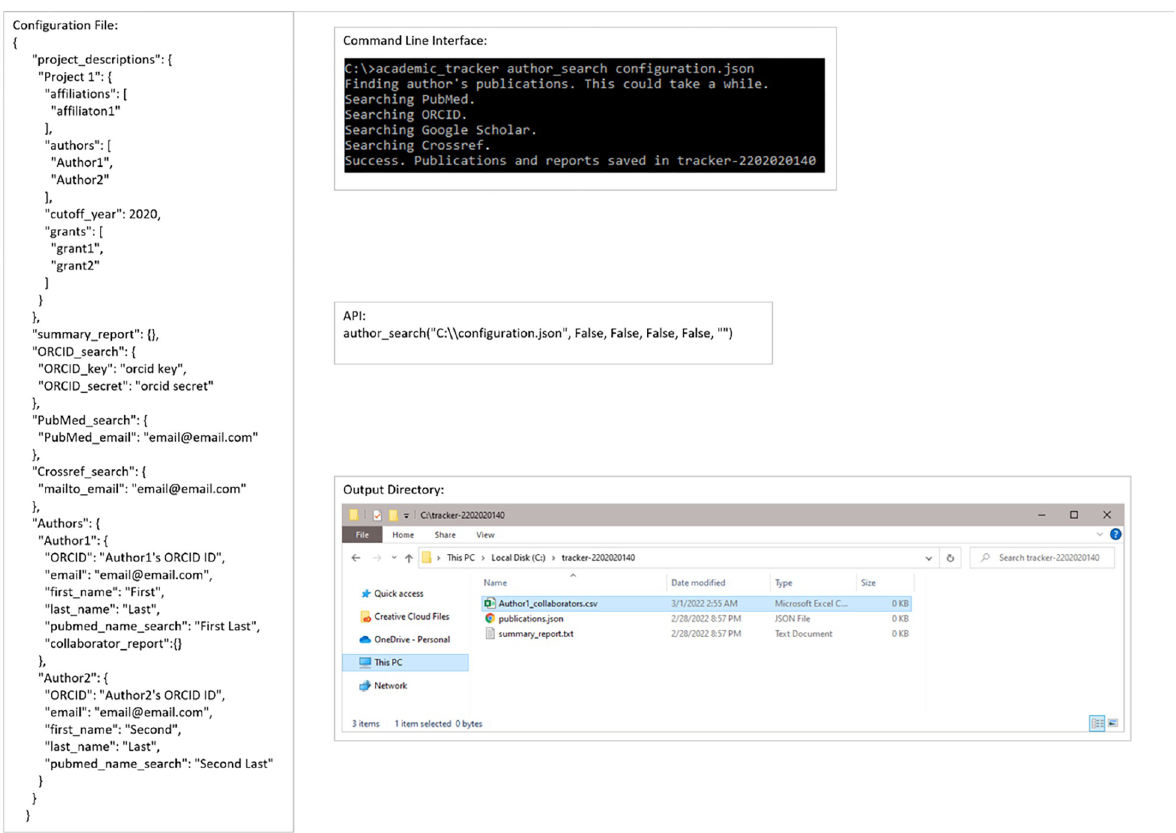
Fig 8. Example execution of collaborator report generation use-case. Example configuration file, command-line execution, API execution, and file output of the author_search for collaborators use-case shown. https://doi.org/10.1371/journal.pone.0277834.g008 PLOS ONE | https://doi.org/10.1371/journal.pone.0277834 November18,